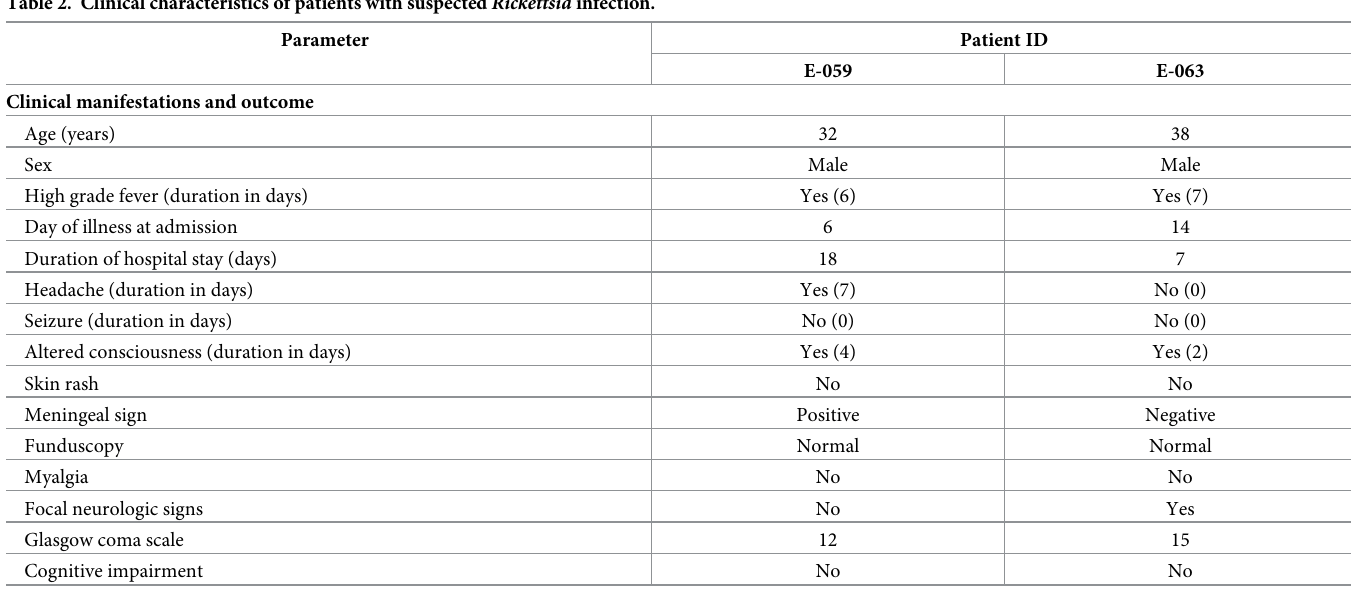
Table 2. Clinical characteristics of patients with suspected Rickettsia